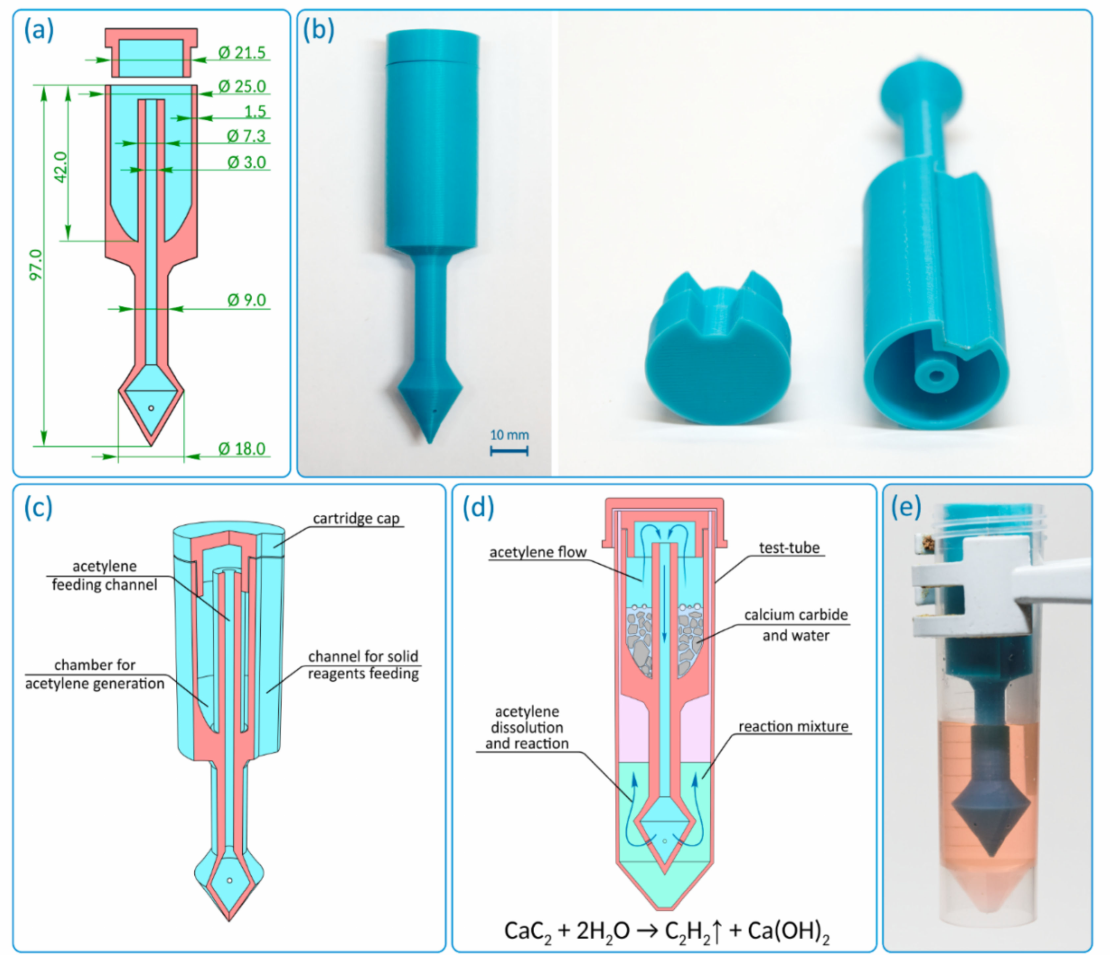
Figure 2. Design of reactor: ( a ) general design of the reactor, ( b ) photo of the 3D printed reactor with polylactide (PLA), ( c ) internal structure of the reactor, ( d ) working principle of the reactor, and ( e ) photo of the ready-to-use 3D printed reactor inside a tube with reaction